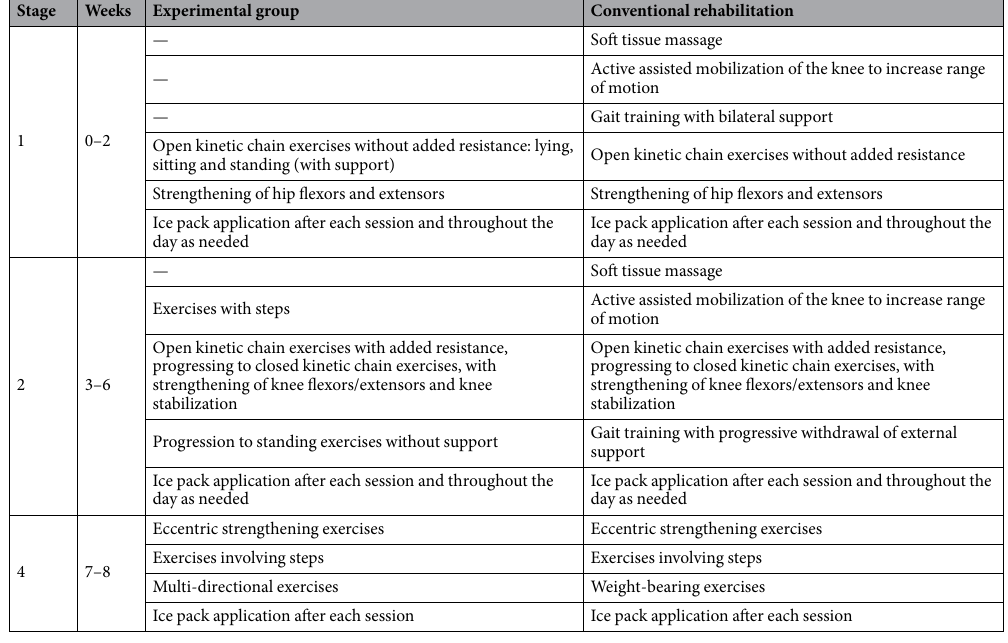
Table 5. Rehabilitation protocols used in the